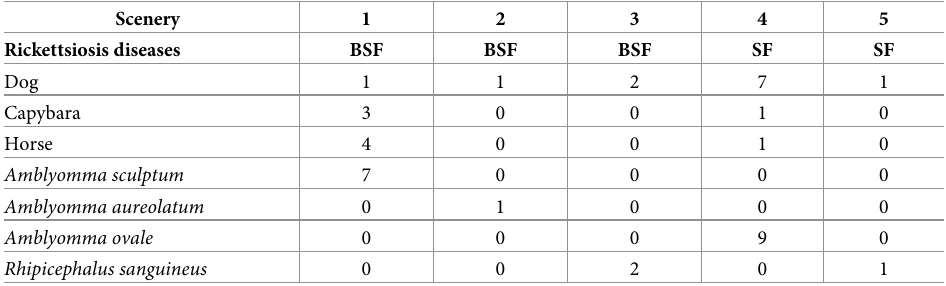
Table 1. Expert panel weighted results for the ecological relationship between spotted fever rickettsiosis vectors and hosts in Rio de Janeiro state, Brazil.